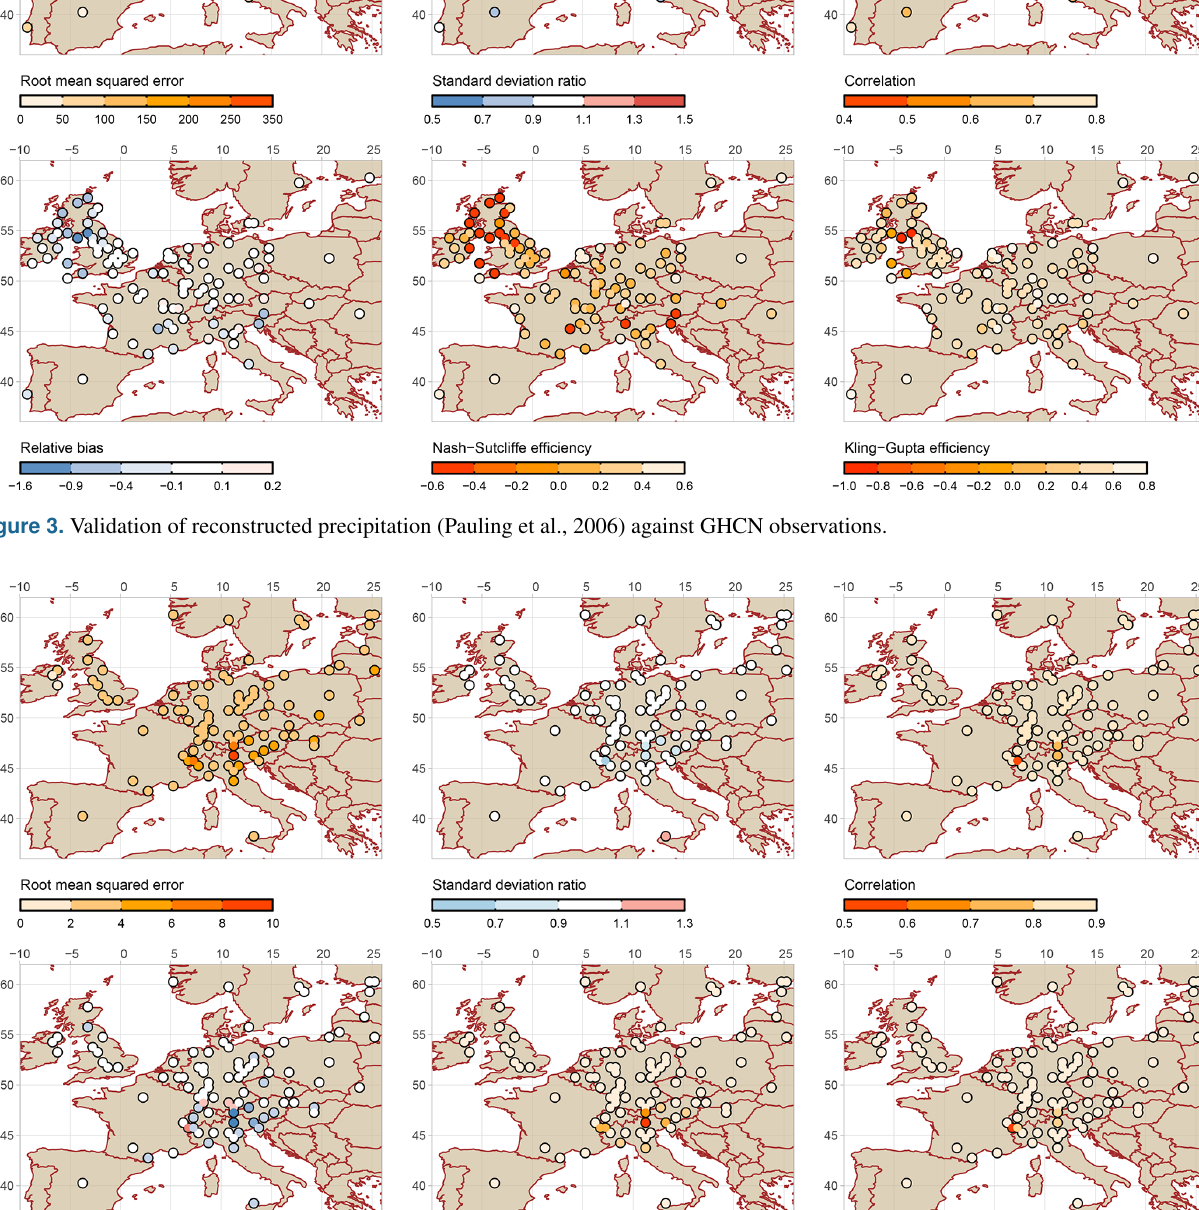
https://doi.org/10.5194/essd-14-4035-2022 Earth Syst. Sci. Data, 14, 4035–4056,